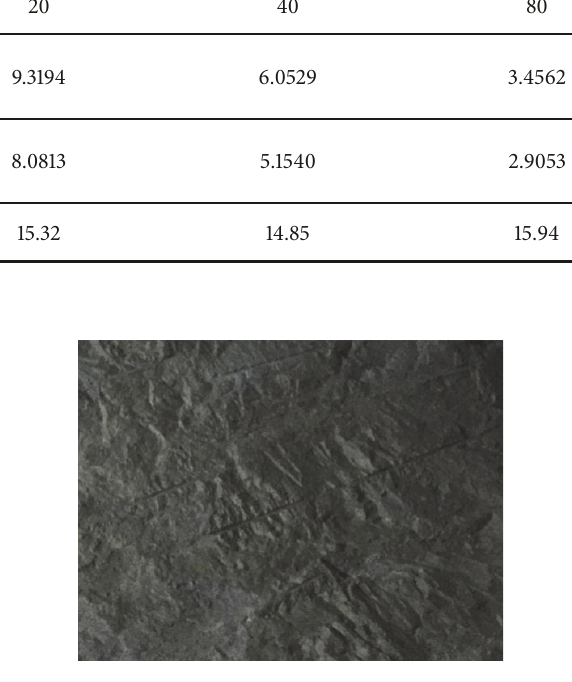
Figure 15: Optimized smooth blasting effect of Grade III surround- ing